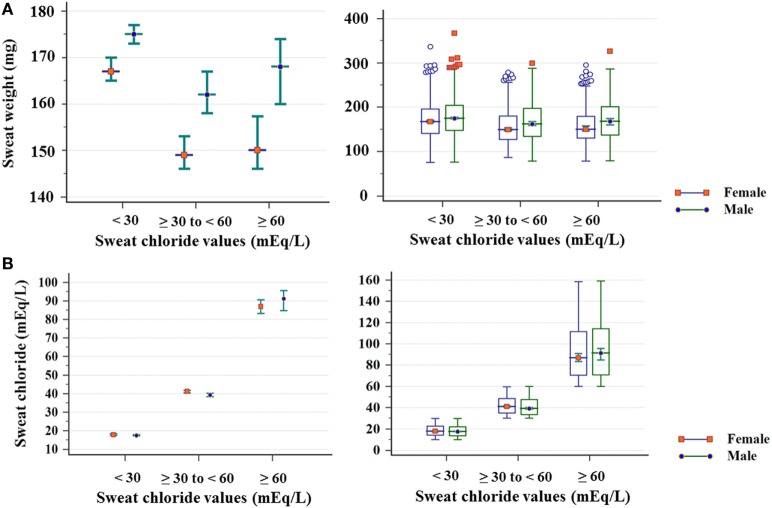
Distribution of sex of subject, considering sweat chloride (mEq/L) and sweat weight. (A) Sweat weight (mg). (chloride <30 mEq/L) Female: N = 1,415; mean of 171 ± 43; median of 167 (amplitude from 75 to 337); male: N = 1,821; mean of 178 ± 43; median of 175 (amplitude from 76 to 367) (p < 0.001); (chloride ≥30 to <60 mEq/L) female: N = 691; mean of 156 ± 38; median of 149 (amplitude from 87 to 279); male: N = 633; mean of 168 ± 44; median of 162 (amplitude from 78 a 299) (p < 0.001); (chloride ≥60 mEq/L) Female: N = 370; mean of 157 ± 39; median of 150 (amplitude from 78 to 295); male: N = 332; mean of 170 ± 44; median of 168 (amplitude from 79 to 326) (p < 0.001). (B) Sweat chloride concentrations obtained in the sweat test. (<30 mEq/L) Female: N = 1,821; mean of 18.15 ± 5.26; median of 17.4 (amplitude from 10 to 29.9); male: N = 1,415; mean of 18.54 ± 5.29; median of 17.7 (amplitude from 10 to 29.9) (p = 0.038); (chloride ≥30 to < 60 mEq/L) female: N = 691; mean of 42.08 ± 8.29; median of 41.1 (amplitude from 30 to 59.8); male: N = 633; mean of 40.89 ± 8.28; median of 39.3 (amplitude from 30 to 59.9) (p = 0.006); (chloride ≥60 mEq/L) female: N = 370; mean of 91.87 ± 24.53; median of 86.85 (amplitude from 60 to 158.6); male: N = 332; mean of 93.28 ± 25.06; median of 91.2 (amplitude from 60 to 159.2) (p = 0.618). The statistical analysis was performed by Mann–Whitney test. α = 0.05. The median is set in red marker and the 95% confidence interval is set in green line. The second graphic is a box plot. mEq/L, milliequivalents per liter.